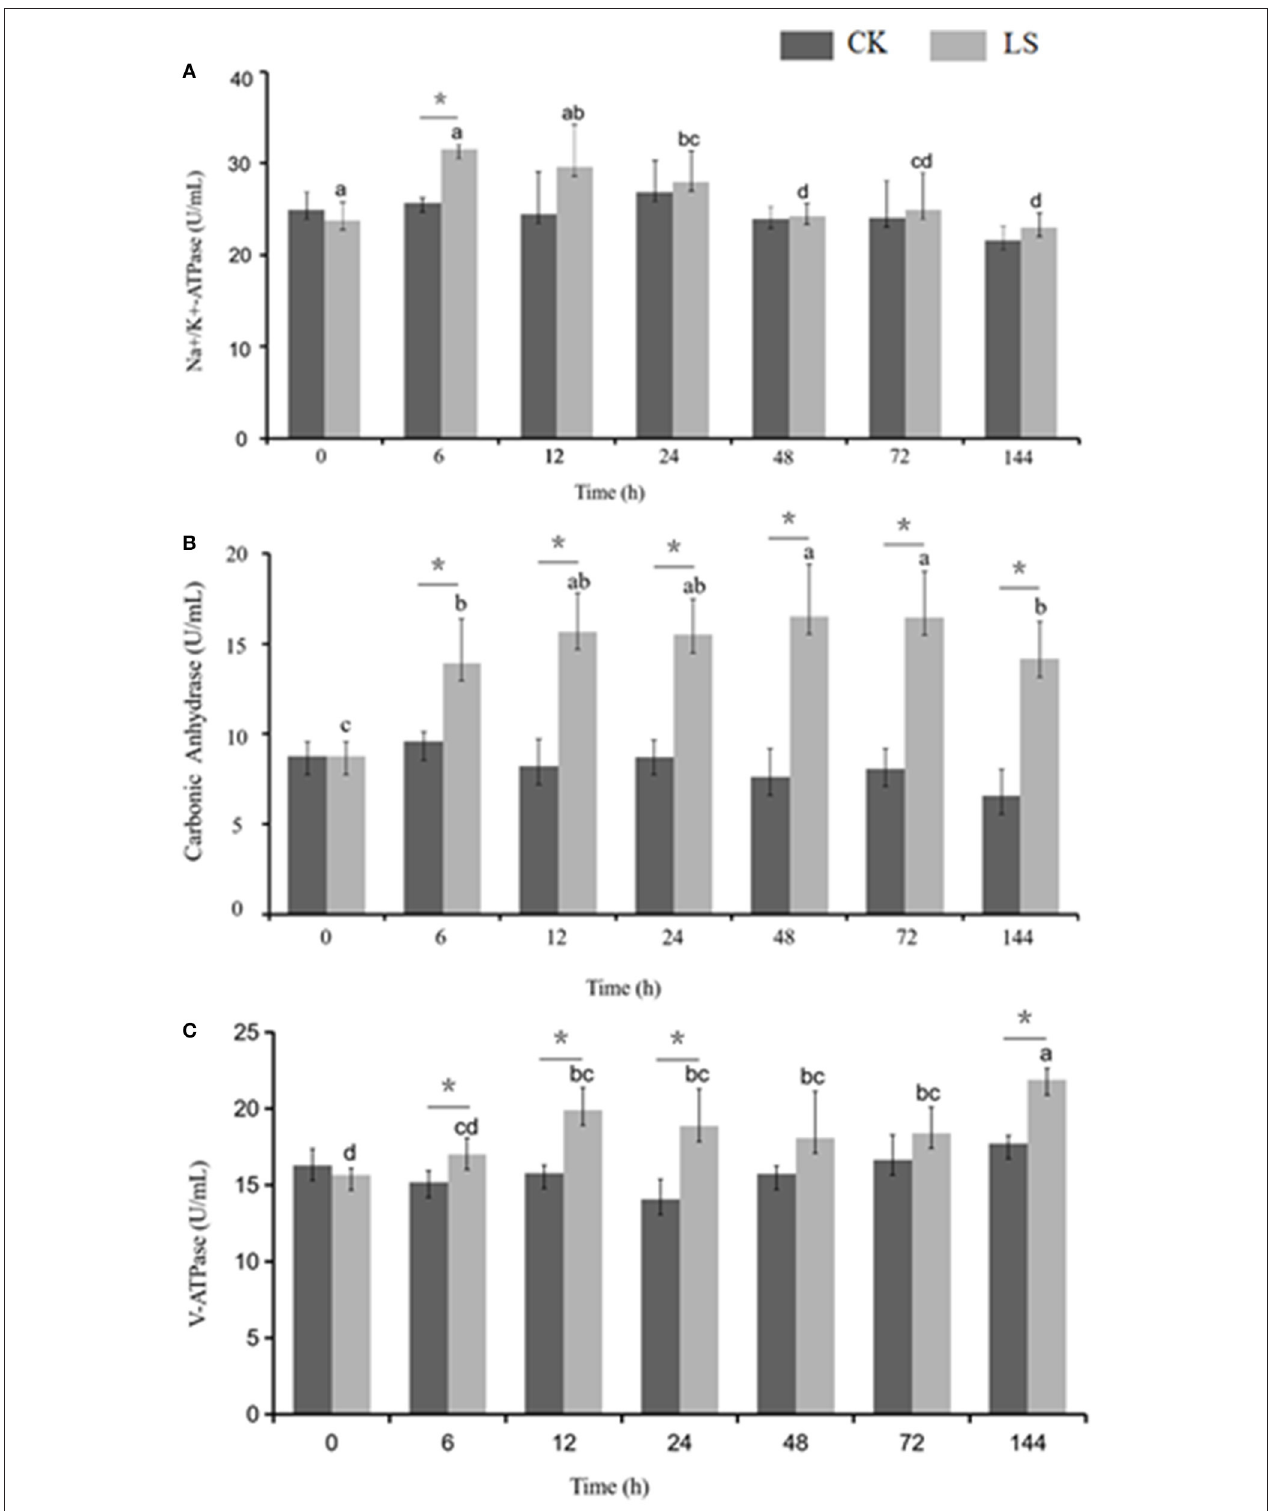
FIGURE 2 | Effect of salinity on the ion transportation enzyme activity in the gills of S.paramamosain . * means significant difference in ion transport enzyme activity with different salinity at the same time.